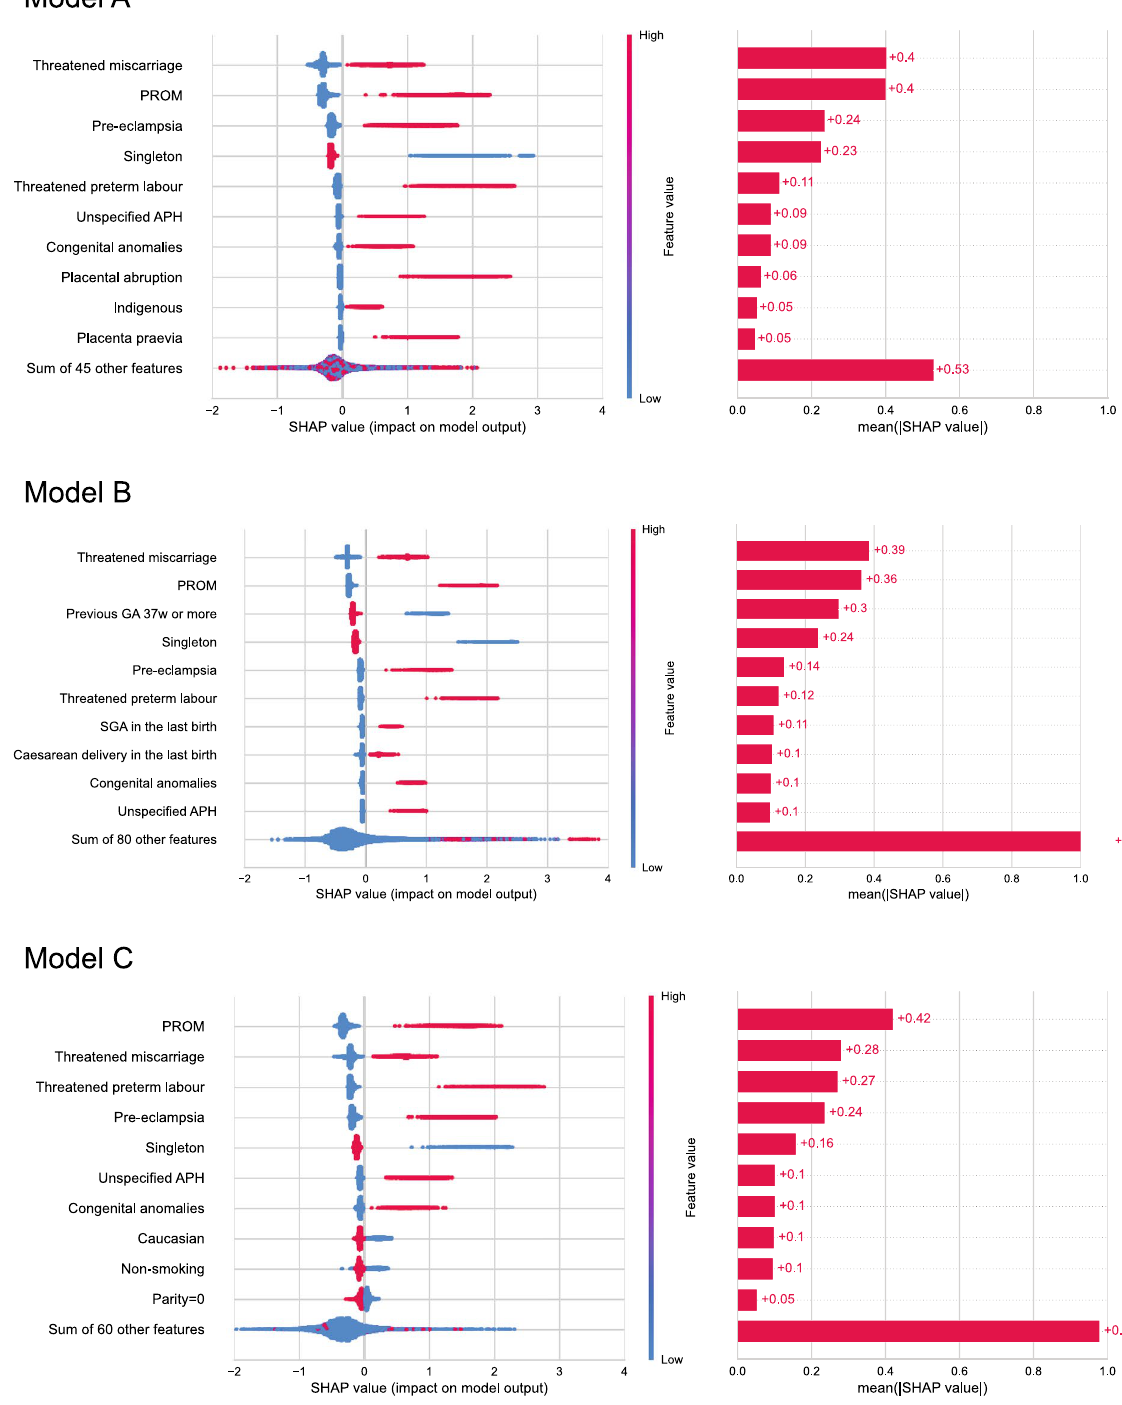
Figure 5. Summary plot of the SHapley Additive exPlanations (SHAP) value for models ( A ), ( B ) and ( C ) developed using the XGBoost classifier. The “beeswarm” plot on the left shows the distribution of the SHAP value (in log-odds scale) calculated using the test dataset. Each dot represents a prediction result of a particular feature for a particular individual. The colour of the dots shows the feature values (red = present/1, blue = absent/0). A positive SHAP value means the predictor increases the likelihood of preterm birth, and a negative value means otherwise. The bar graph on the right side shows the mean absolute SHAP value for each feature. The feature names are displayed on the far left in order of the mean absolute value. PROM, pre-labour rupture of membrane; APH, antepartum haemorrhage; GA, gestational age; SGA, small for gestational age; w,